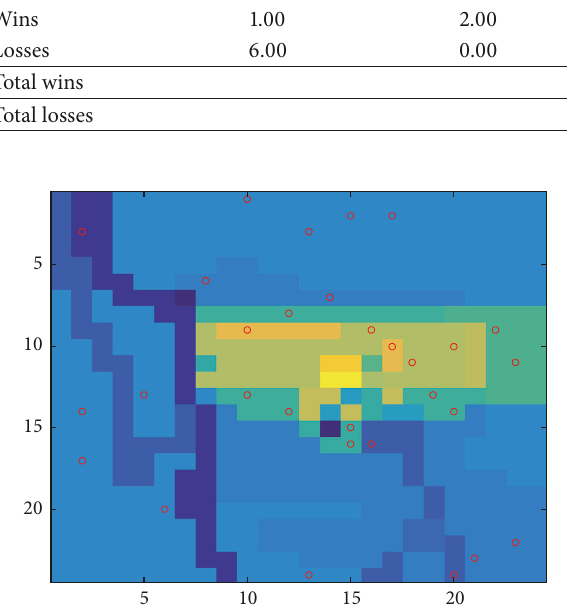
Figure 14: La Palma missing people.